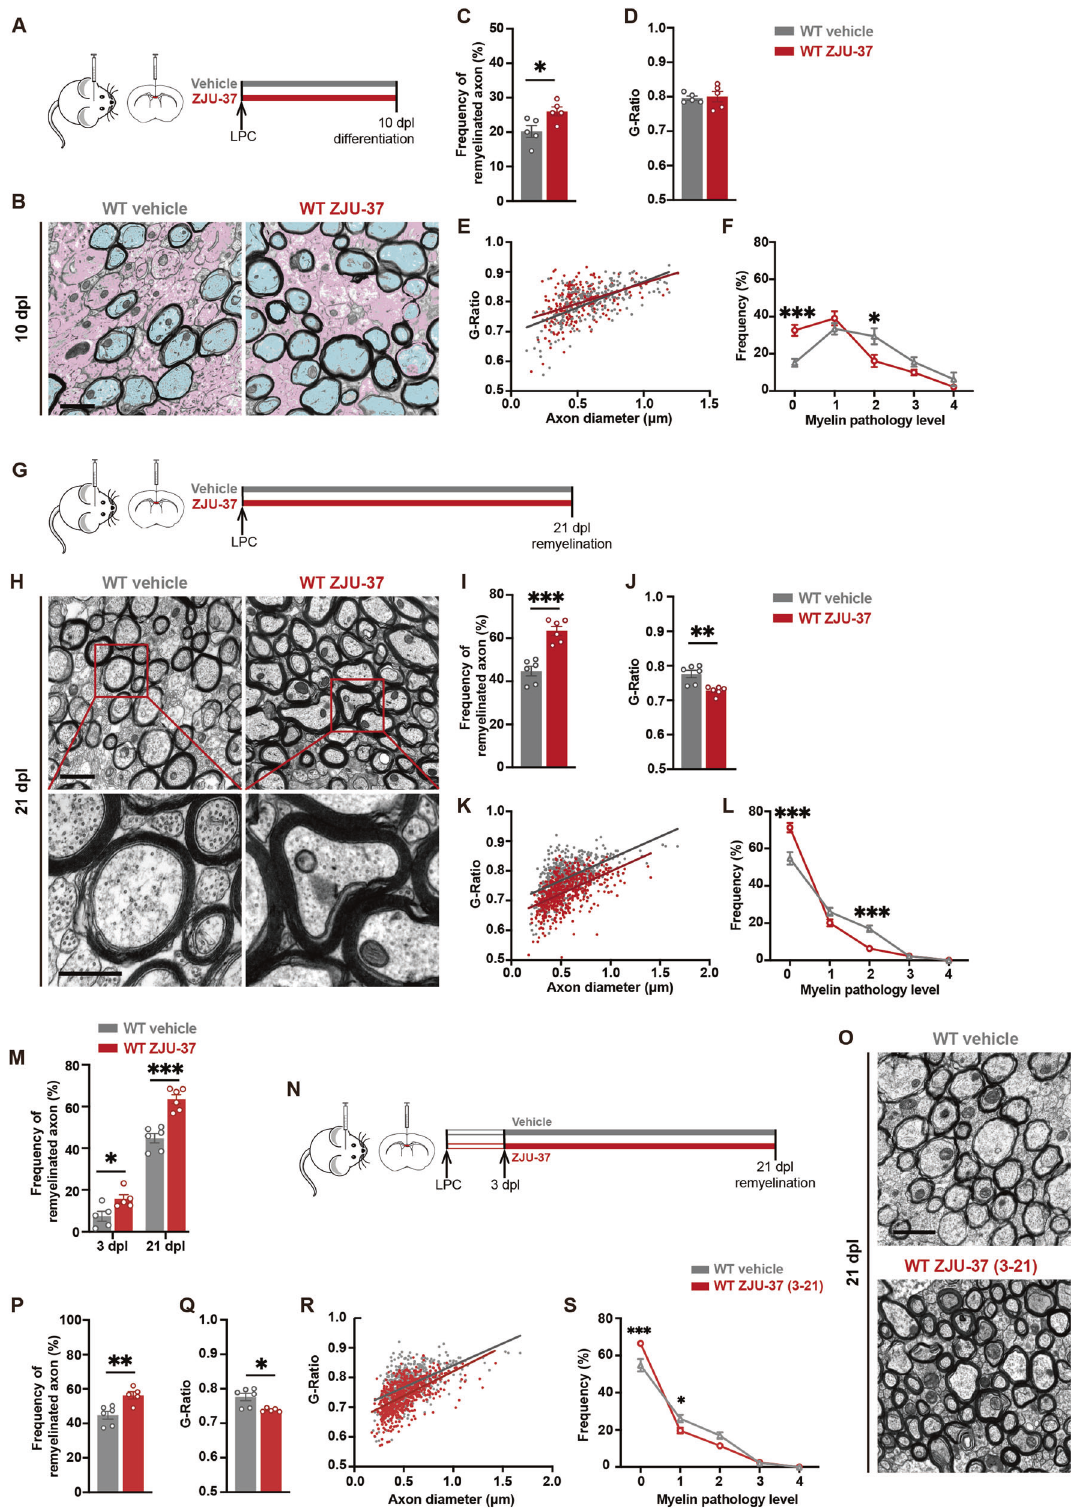
whether NF- κ B involves in ZJU-37 upregulating PDGFR α . We showed that ZJU-37 upregulated PDGFR α in OPCs of WT mice but did not affect PDGFR α in OPCs of RIPK1 D138N mice (Fig. 7H). By using caffeic acid phenethyl ester (CAPE), an inhibitor of NF- κ B, we